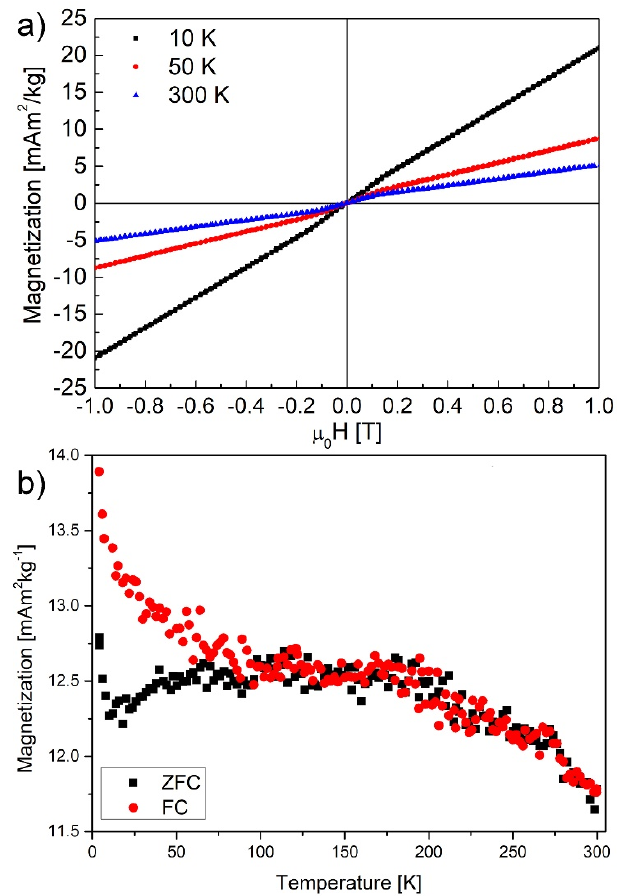
Figure 5. ( a ) Magnetic moment vs. magnetic field dependence recorded in the range of ±1 T for 10, 50, and 300 K; ( b ) Zero Field Cooling (ZFC) and Field Cooling (FC) curves obtained in 3 kOe in a temperature range of 5–300 K of reduced graphene oxide fibers.